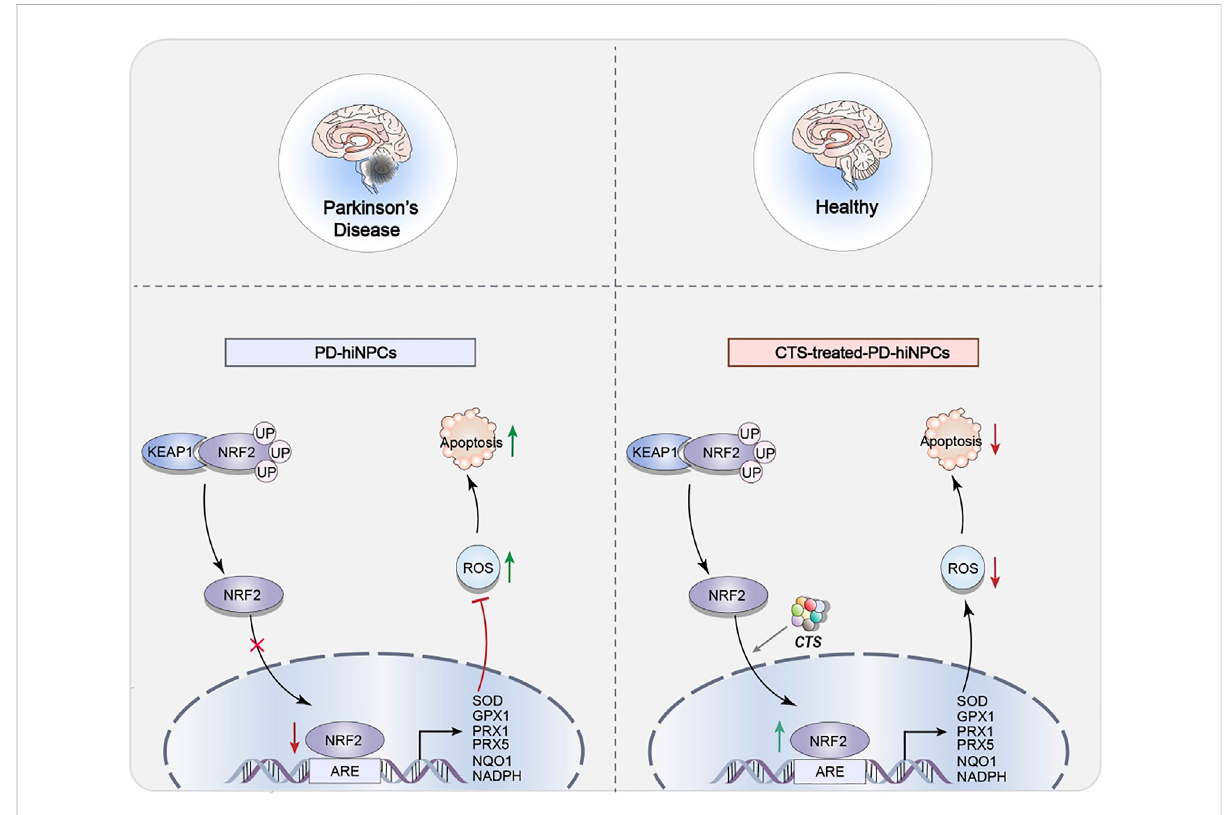
FIGURE 4 Representative scheme illustrating CTS ’ s inhibitory role in the apoptosis of NPCs by regulating the NRF2 signaling pathway for the treatment of parkinson ’ s